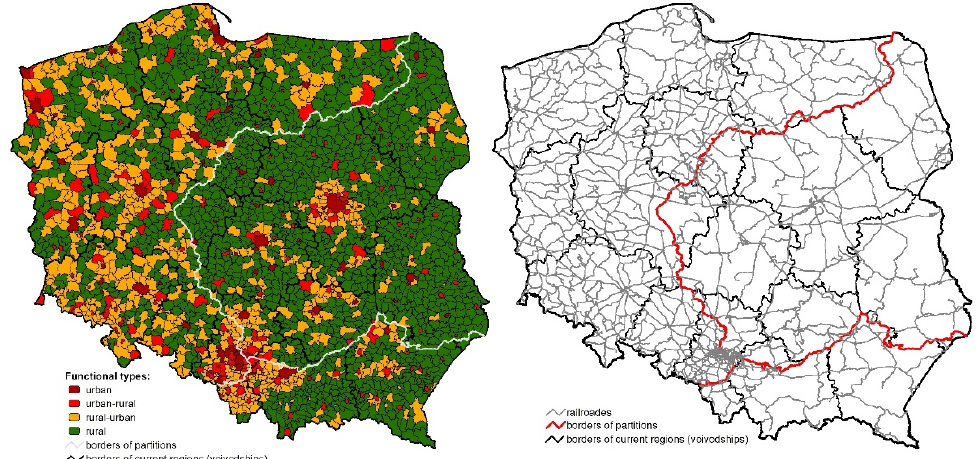
Figure 2. Railway network and types of functional units in Poland. Source: own elaboration, based on [25,26].